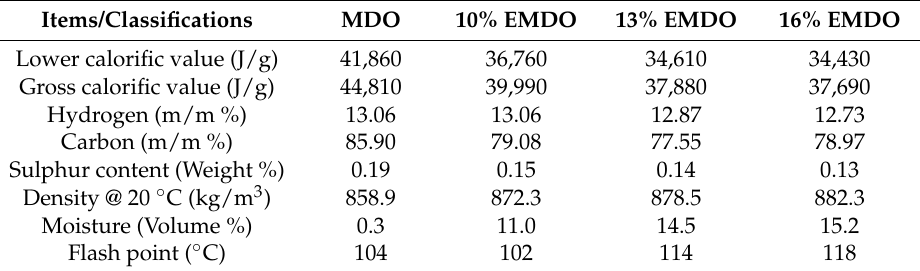
Table 1. Specifications of fuel oil used in this study.